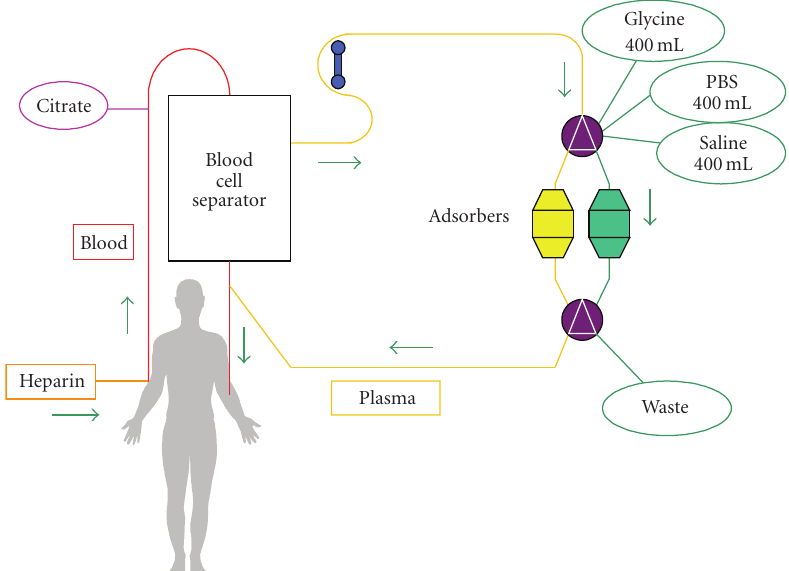
Figure 1: Our modification of immunoadsorption (modified by Borberg et al. [9, 10]). Vascular access for the extracorporeal circuit is established via two peripheral veins. Plasma without cellular elements obtained after high-speed centrifugation with a quality separator (Cobe-Spectra, Denver, USA) is drawn through an adsorbent Adsopak capsule. Plasma flow is continuous. After filling the adsorbent capsule, the Adasorb device (Medicap, Ulrichsteinn, Germany) switches automatically to the second adsorbent capsule; the first capsule is washed with glycine, PBS bu ff er, and saline to prepare it for reuse so the procedure can be repeated as necessary. Regeneration solutions are drained into a waste bag. Clean, washed plasma flows from the column back to the separator where it is mixed with blood elements and returns to the patient’s peripheral veins. Anticoagulation is maintained by a continuous supply of citrate solution (ACD-A Baxter, Germany), and it is secured by an initial application of 2500 U heparin i.v., subsequent continuous infusion of 50 U of heparin/min and gradual dose lowering such that heparin application ceases in the middle of